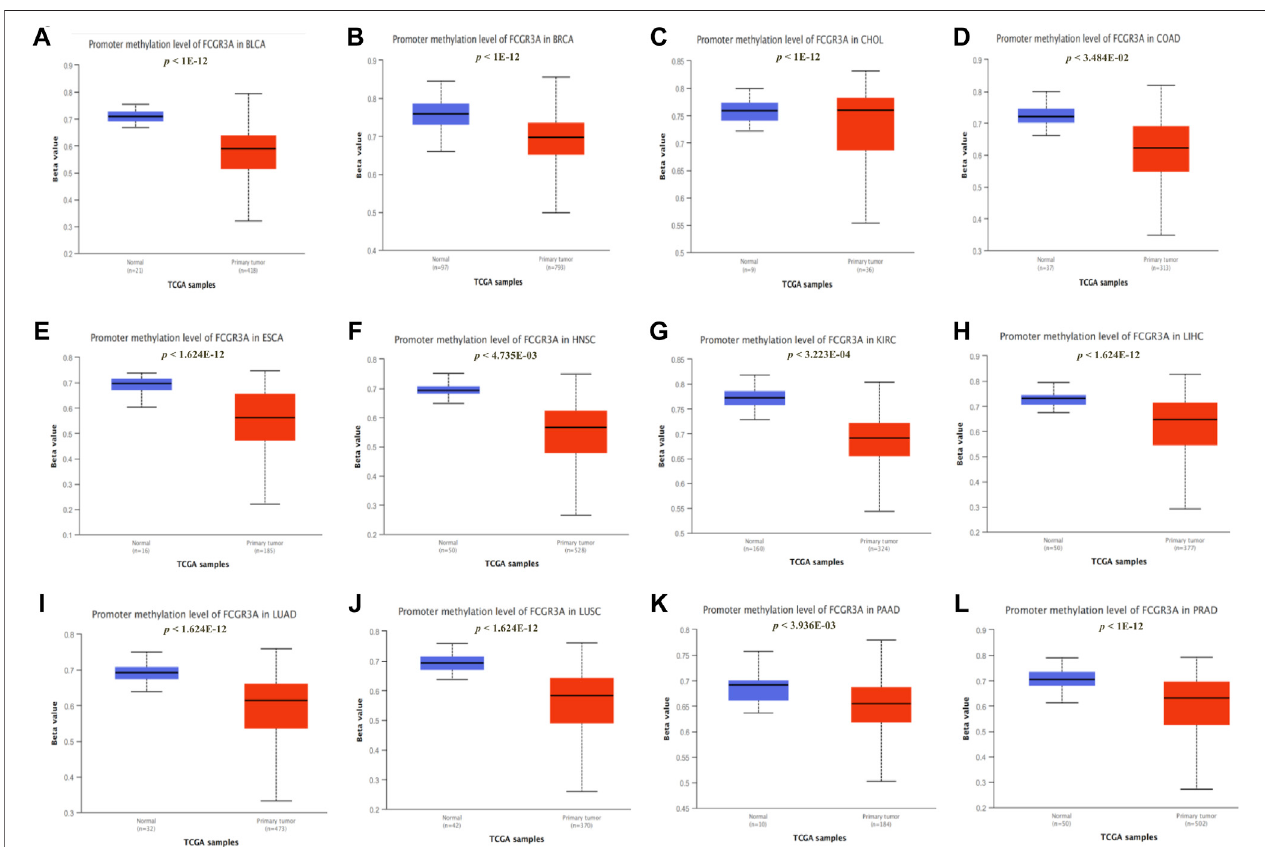
FIGURE 7 | Correlation between FCGR3A expression and gene promoter methylation. (A) Bladder urothelial carcinoma (BLCA); (B) Breast invasive carcinoma (BRCA); (C) Cholangiocarcinoma(CHOL); (D) Colonadenocarcinoma(COAD); (E) Esophagealcarcinoma(ESCA); (F) Headandnecksquamouscellcarcinoma(HNSC); (G) Kidney renal clear cell carcinoma (KIRC); (H) liver hepatocellular carcinoma (LIHC); (I) Lung adenocarcinoma (LUAD); (J) Lung squamous cell carcinoma (LUSC); (K) Pancreatic adenocarcinoma (PAAD); (L) Prostate adenocarcinoma